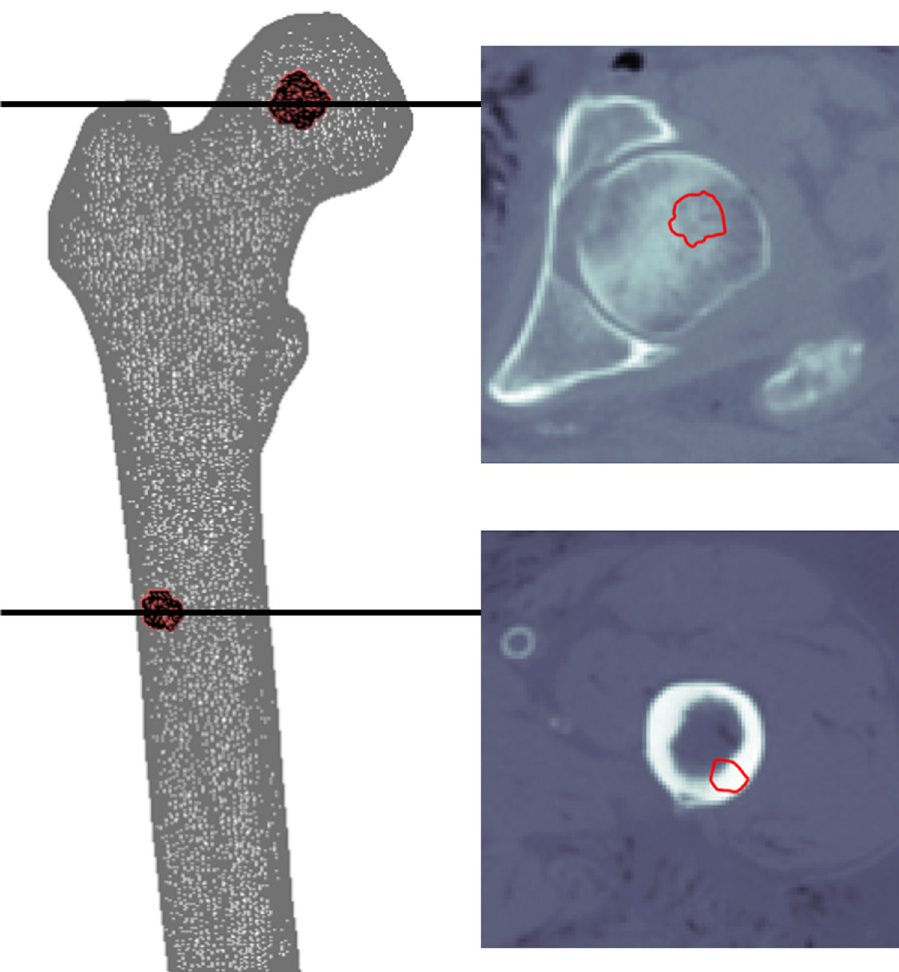
Fig 3. An example of the trabecular (upper) and cortical (lower) regions of interest including axial views. failure load after air-fat-muscle calibration compared to phantom calibration. Higher correla- tions between phantom and air-fat-muscle calibration were obtained when excluding femur 5 (S1 Fig). The average failure load for the standard protocol was 6632 N (range 3967 to 10218 N) after phantom calibration, 7110 N (range 3759 to 11297 N) after air-fat-muscle calibration and 7505N (range 4749N to 11136 N) after non-patient-specific calibration. The difference in fail- ure load relative to the standard protocol varied between femurs (Fig 7). Maximum mean fail- ure load variations from the standard protocol were 4.7% for phantom calibration, 13.8% for air-fat-muscle calibration, and 13.4% for non-patient-specific calibration. Most noticable were the relatively large decreases in failure load with 13.8% and 13.4% when changing kVp from 120 to 140 after air-fat-muscle and non-patient-specific calibration, respectively.